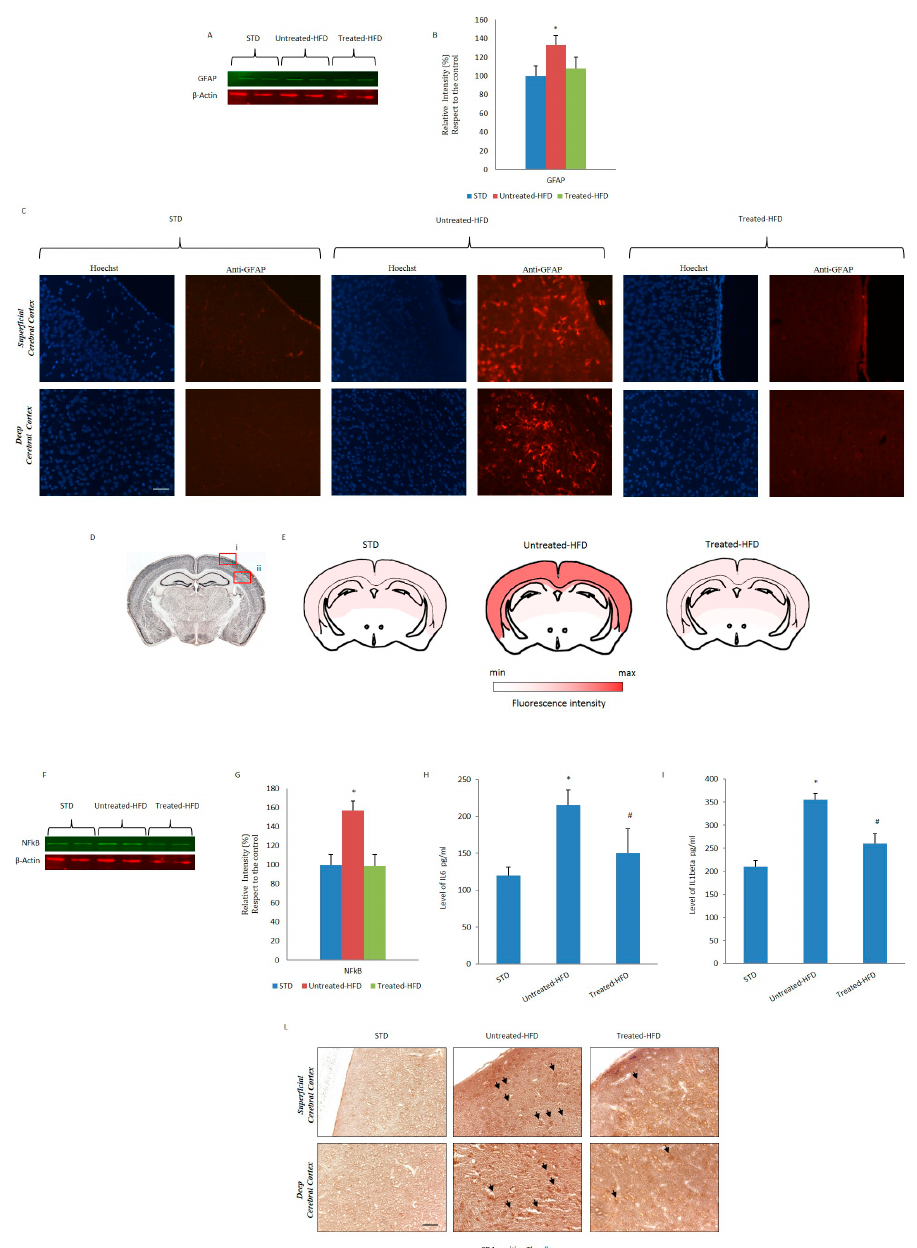
Figure 5. NDS prevents HFD-induced inflammation and immunological response in the brain. ( A ) Western blot of proteins extracted from brains of STD, untreated-HFD and treated-HFD mice and incubated with anti-GFAP and anti- β -Actin (loading control); ( B ) Quantification of immunoreactivity was performed using densitometric analysis; ( C ) Immunofluorescence of superficial and deep cerebral cortex sections incubated with anti-GFAP; ( D ) Schematic representation of superficial (i) and deep (ii) cerebral cortex positive areas; ( E ) Brain map indicating the levels of positive staining of GFAP; ( F ) Western blot of proteins extracted from brains of STD, untreated-HFD and treated-HFD mice and incubated with anti-NFkB and anti- β -Actin (loading control); ( G ) Quantification of immunoreactivity was performed using densitometric analysis; ( H , I ) Levels of IL-6 and IL-1 β in brains of STD, untreated-HFD and treated-HFD mice, quantified by ELISA assay. ( L ) Brain sections from STD, untreated-HFD and treated-HFD mice incubated with anti-CD4. Representative images from 3 animals per group are shown. Bar 20 μ m. Data are the mean values ± SD ( n = 8/group). * p ≤ 0.05 vs. STD. # p ≤ 0.05 vs untreated-HFD.